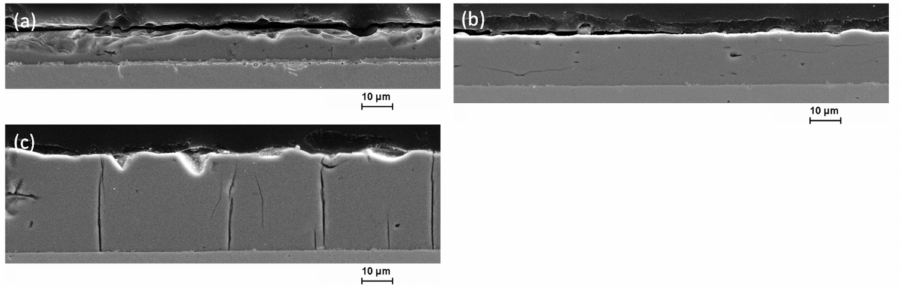
Figure 4. Scanning electron microscopy micrographs of cross-sections of electrodeposited Fe-Cr-Ni coatings under DC conditions for three depositions ( a ) after first 2 h of electrolyte use and clear material chipping; ( b ) after second 2 h with slight vertical microcracks and ( c ) after third 2 h with clear